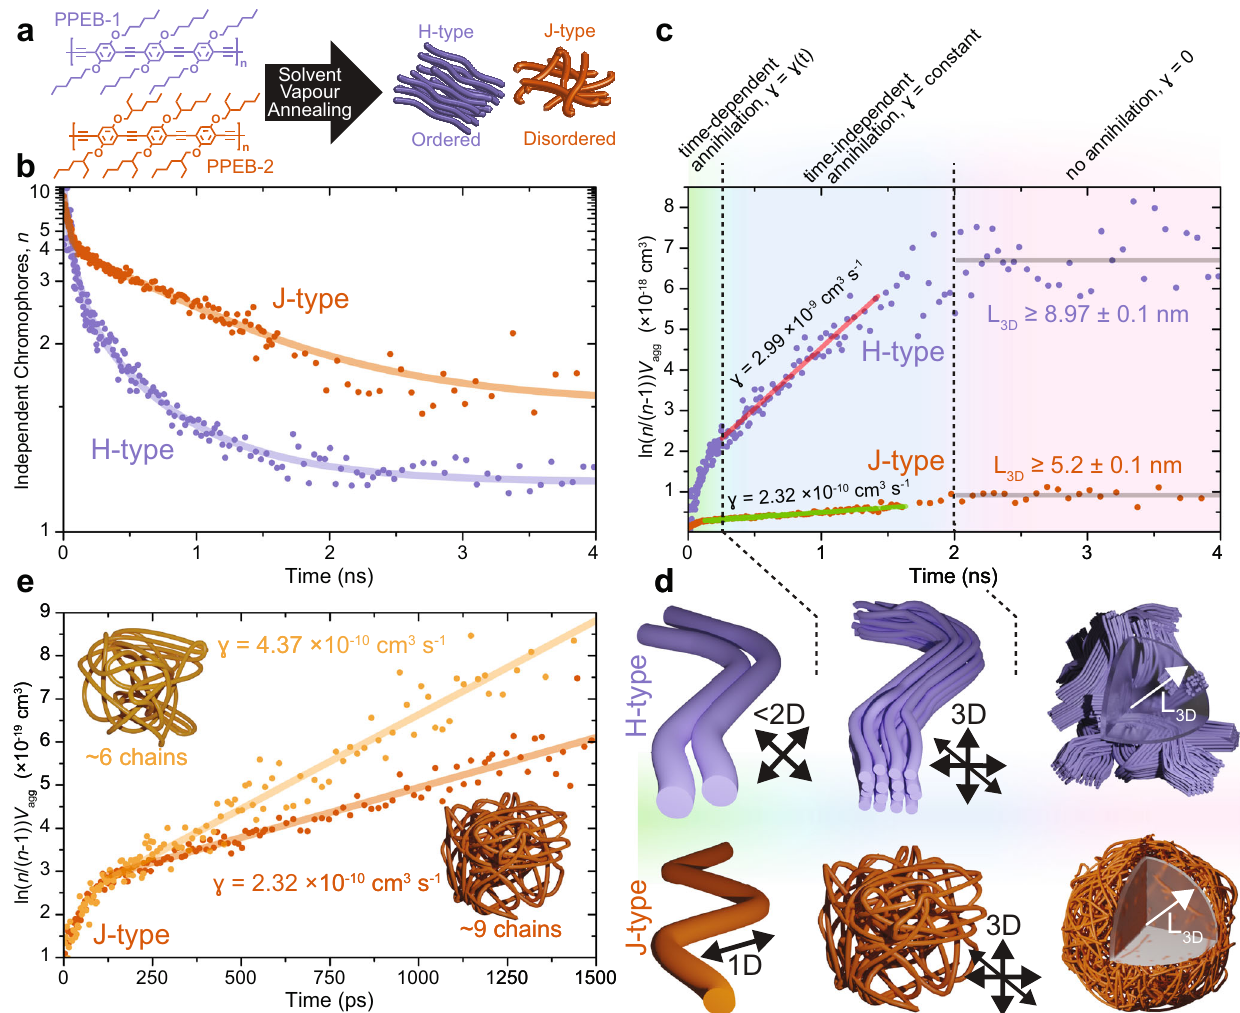
Fig. 4 Following exciton diffusion dynamics in isolated conjugated polymer aggregates. a PPEB polymers that are grown into H-type (PPEB-1, lilac) or J- type (PPEB-2, brown) aggregates by solvent vapour annealing. b Temporal evolution of the number of independent chromophores in the aggregate, determined by psTRAB, for the H-type and J-type aggregates. A signi fi cant difference in the dynamics is observed, with lines being guides to the eye. (cid:4) (cid:5) (cid:3) V c Plotting of the time-dependent quantity ln n n (cid:1) agg for the H- and J-type aggregates. The gradients of the curves correspond to the exciton annihilation 1 rate, γ , of diffusion-controlled annihilation. Three regions of the dynamics are identi fi ed: at early time (0 – 250 ps), γ is time-dependent; at intermediate times (250 – 2,000 ps) γ is constant and tenfold higher in the H- compared to the J-type aggregate; and at late times (> 2000 ps) γ is zero. These regions are interpreted in d , indicating that early-time diffusion is one- or less than two-dimensional and intermediate time diffusion is three-dimensional; at late times annihilation ceases because the exciton density is too low. The latter range provides a lower limit of the three-dimensional diffusion length, L 3D . In e the nine-chain J-type aggregate shown in panel c (brown) is compared with a smaller six-chain J-type aggregate (orange). The gradient ( γ ) is a factor of two smaller in the larger aggregate, indicating that three-dimensional diffusivity is reduced when more chains are present. This reduction is consistent with reduced ordering of the chains as the aggregate size grows, and thus reduced interchain coupling. The six-chain dataset is made up of 260 individually measured single